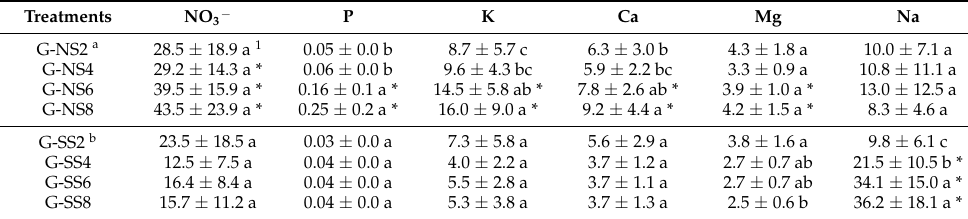
Table 1. Mean values ( ± SE) of the nutrient concentrations (mmol L − 1 ) found in the drainage solution resulting from plants irrigated by means of G-NS and G-SS during the first period.